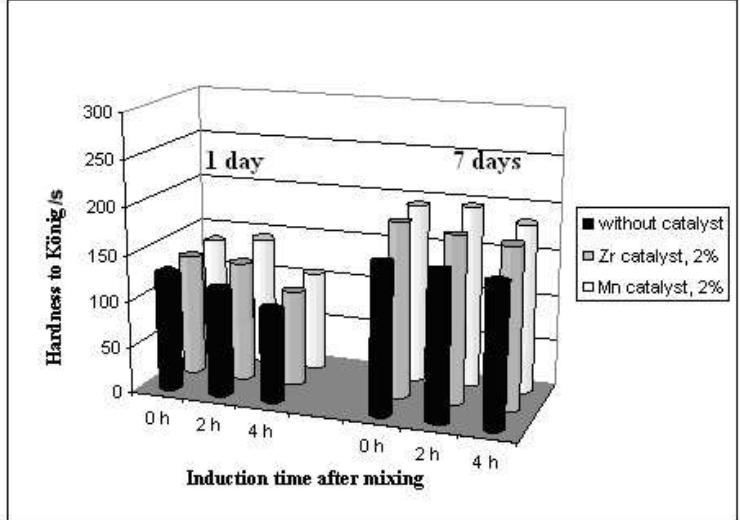
Figure 7 . The effect of the potlife on the hardness of the two-component PUR composition coating based on the Polyol*1 (PUR 1), without the catalyst, with the zirconium catalyst K-KAT ® XC-6212 and with the manganese based catalyst (30µm dry film